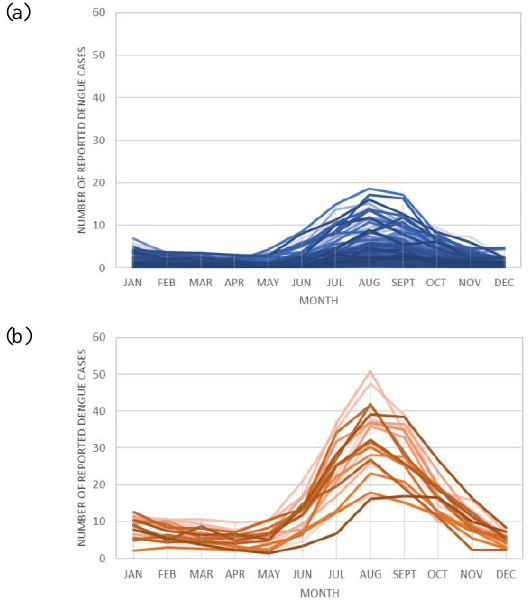
Figure 6. Monthly average reported dengue cases of each barangays in a) Cluster 1 b) Cluster